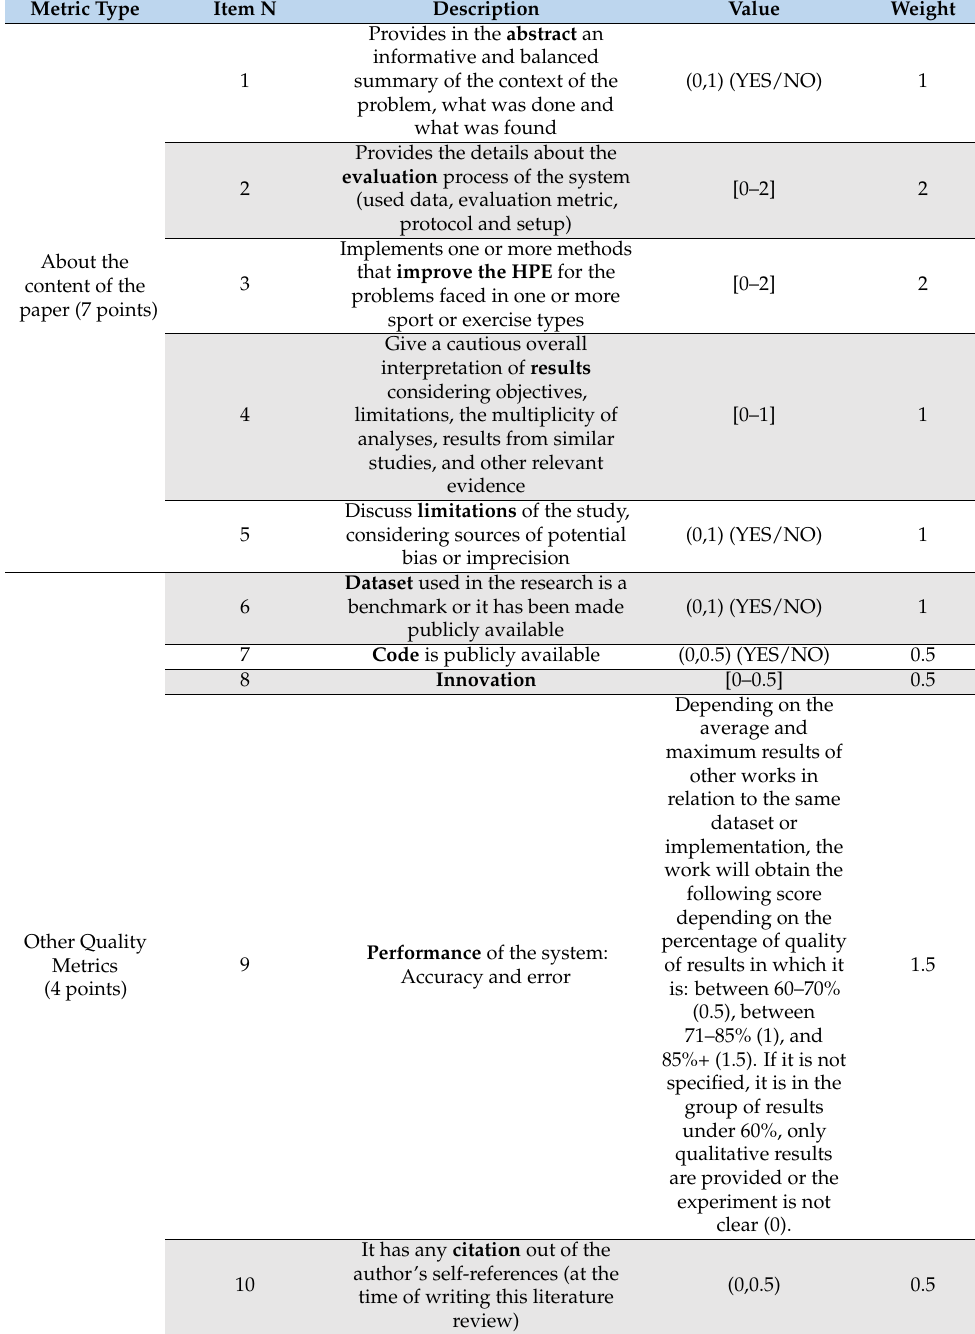
Table 2. Paper and work quality